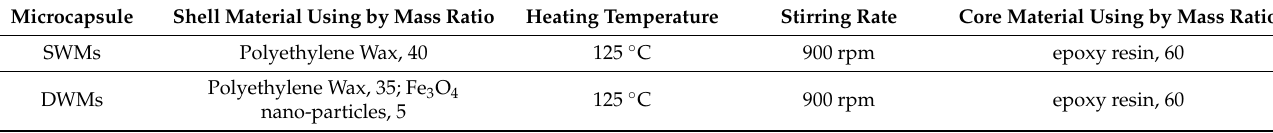
Table 1. Preparation parameters of microcapsules.